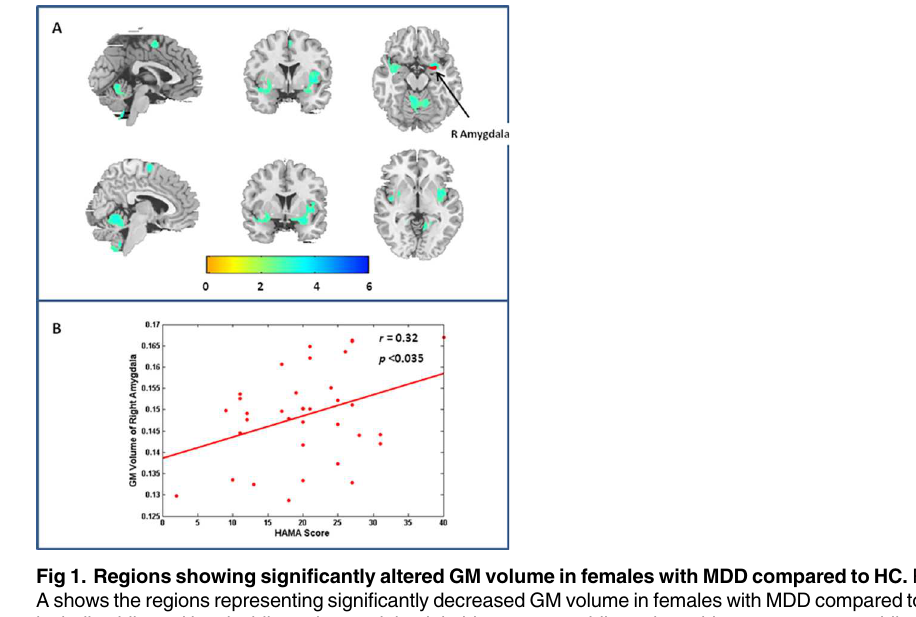
In following-up analysis on resting-state brain activity, the right amygdala was chosen as the seed region. Low frequency functional connectivity maps for the whole brain were generated for each group. As Fig 2 and Table 3 demonstrate, females with MDD displayed attenuated